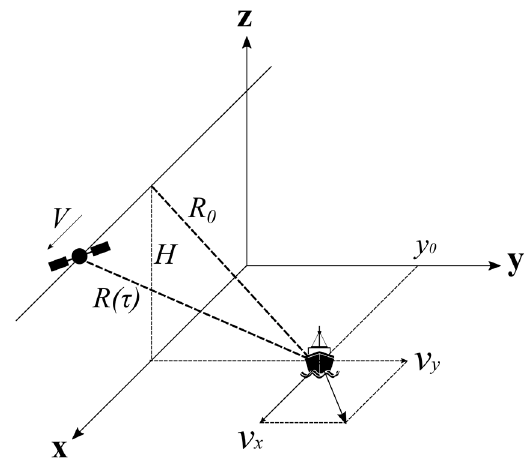
Figure 1. A stripmap synthetic aperture radar (SAR) observation geometry for a ground moving object.